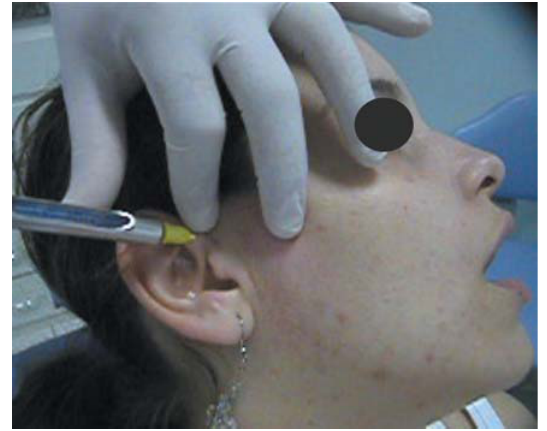
FIGURE 2 - Infiltration of the anesthetic solution